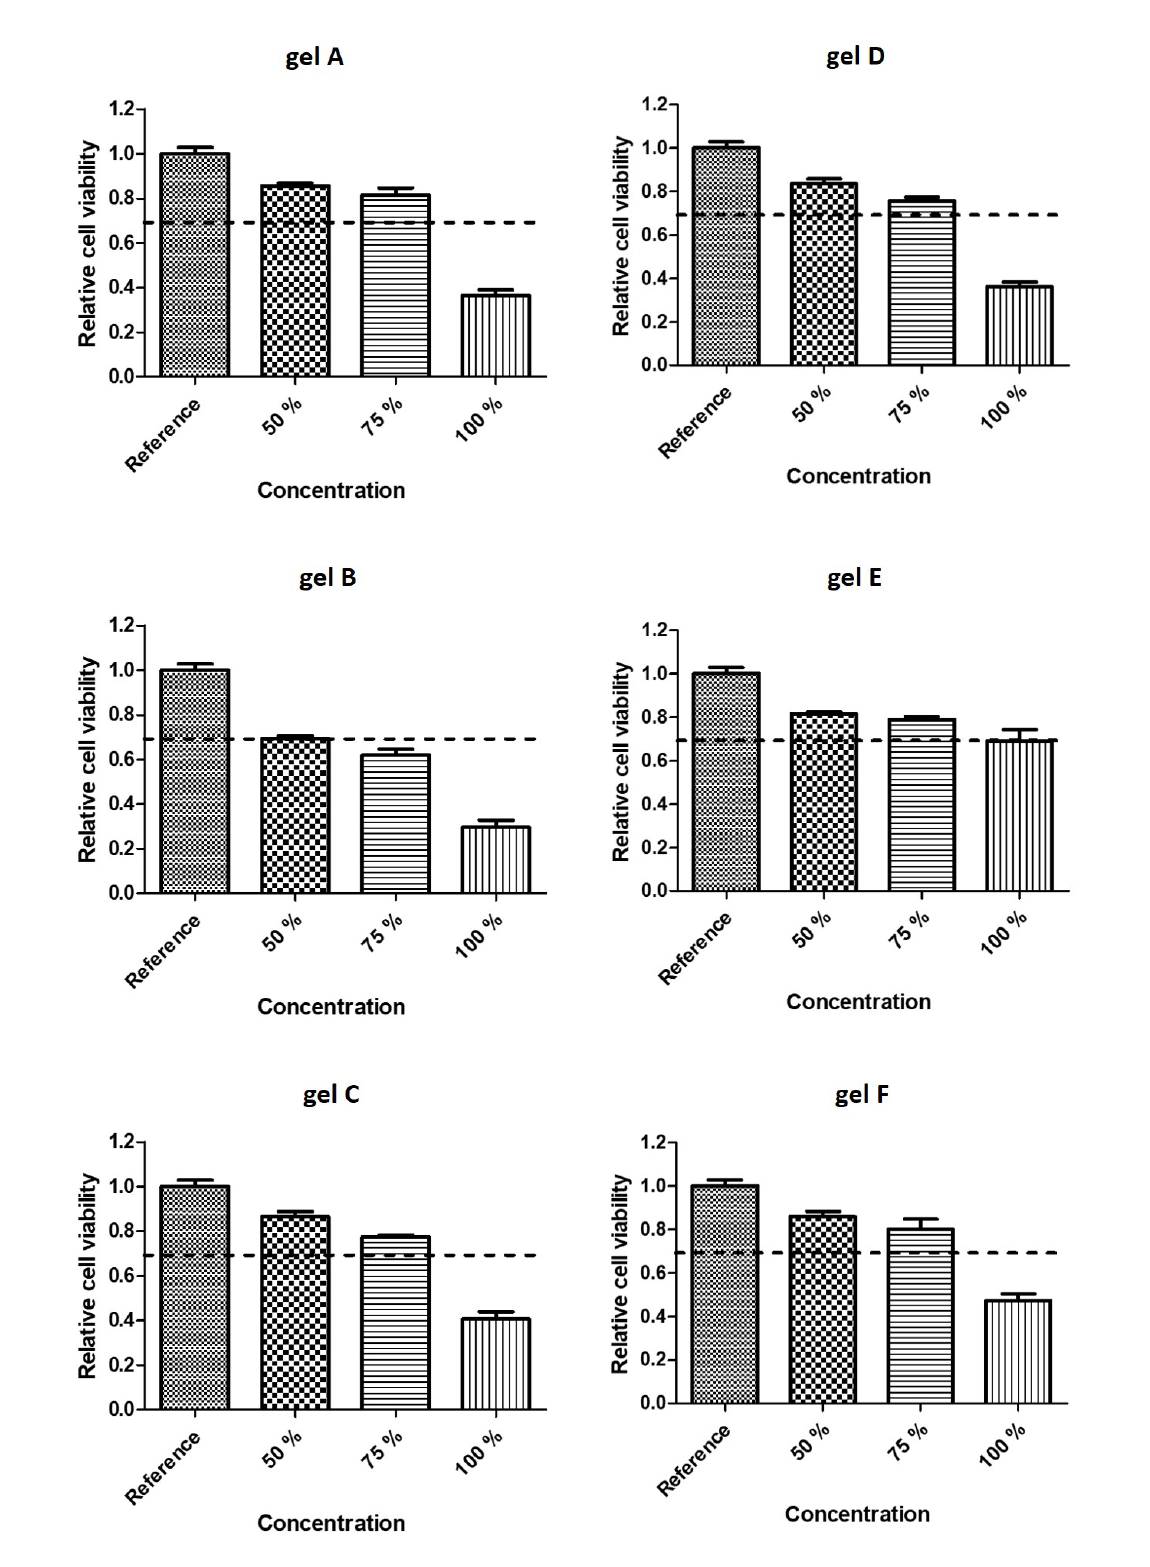
Figure 8. Cytotoxicity of dually cross-linked